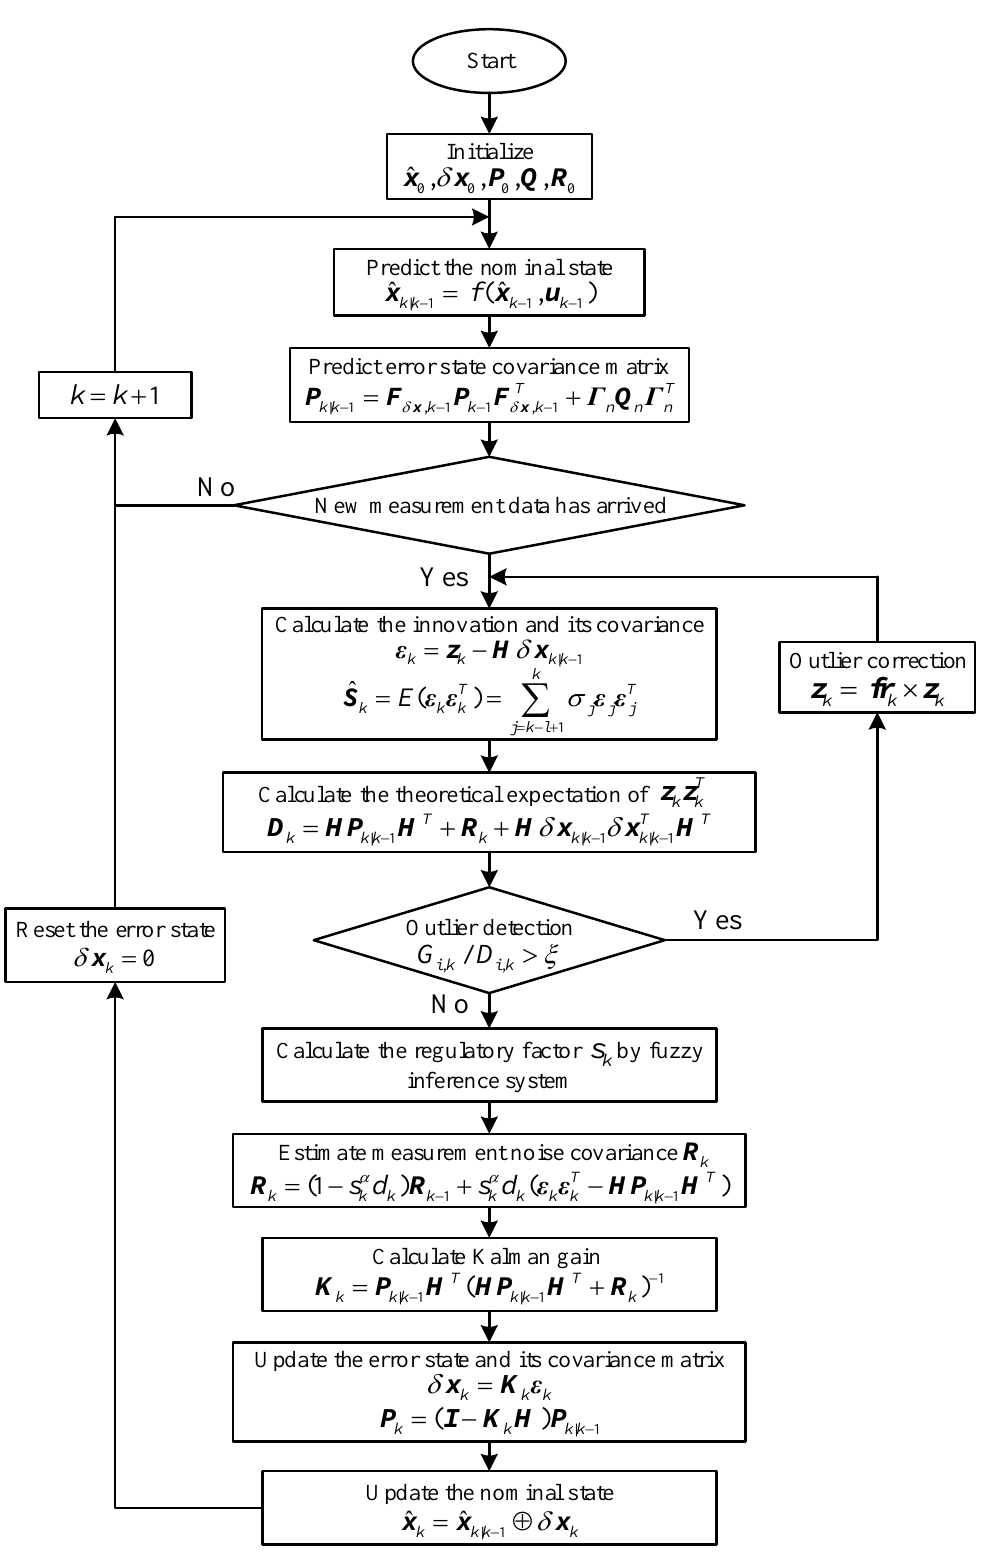
Figure 5. The flowchart of Sage–Husa fuzzy adaptive error state Kalman